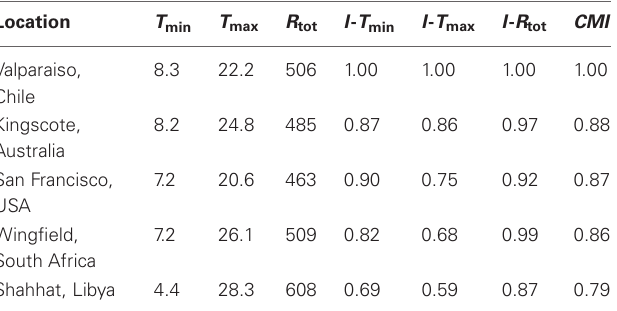
Table 2 | The similarity of locations to Valparaiso, Chile: Temperature, rainfall, and similarity indices a .